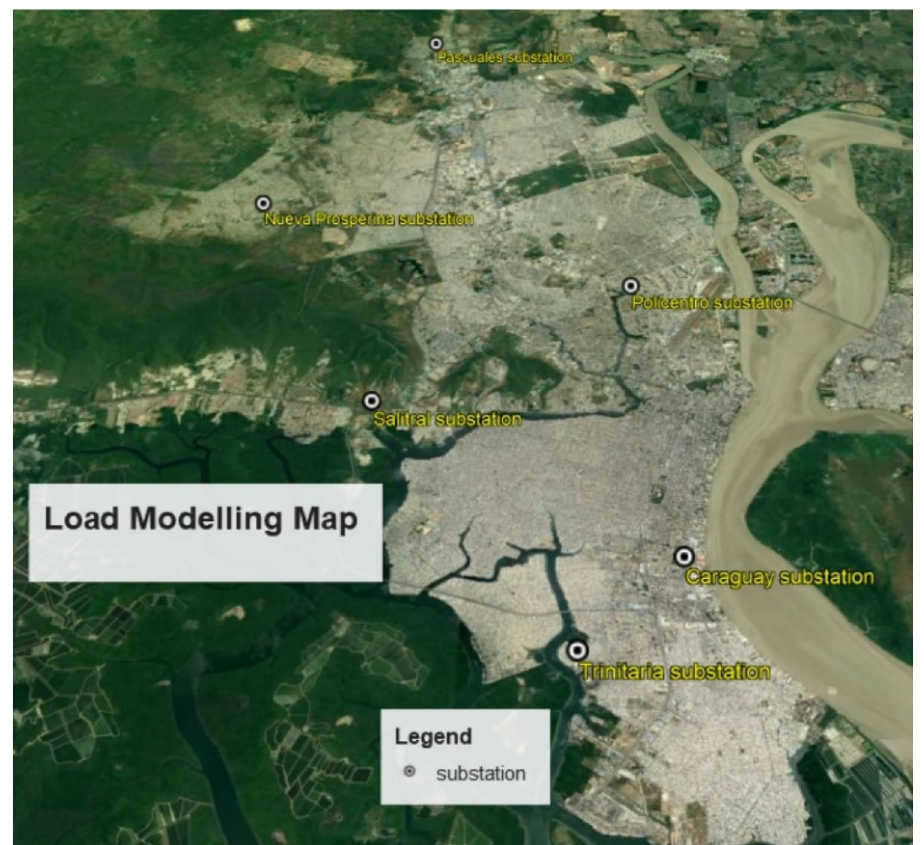
Figure 1. Google Earth oblique image of Translectric substations entry points to Guayaquil 20